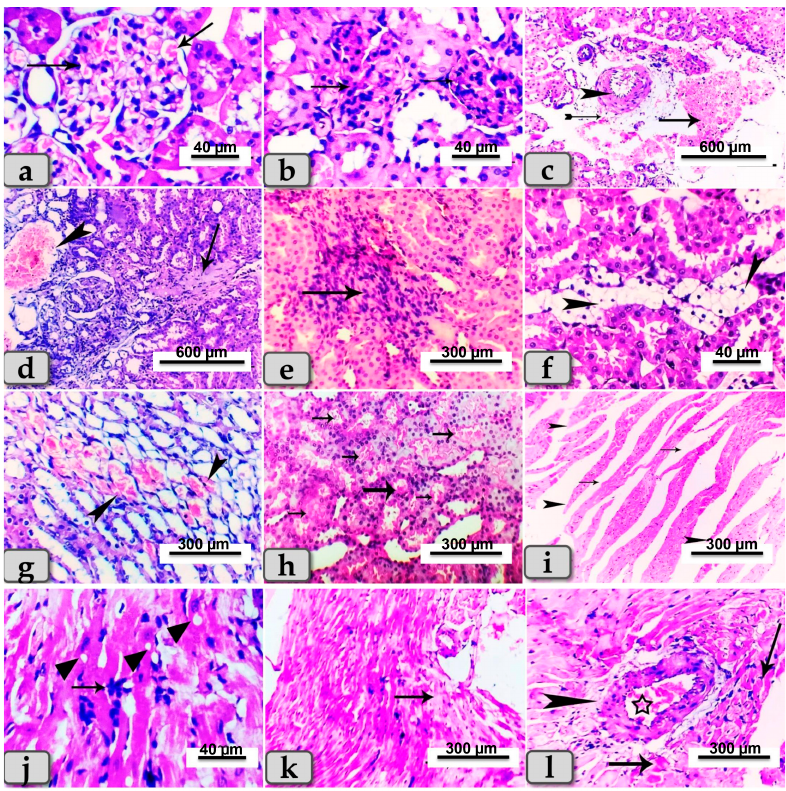
Figure 5. Photomicrographs of kidney and hearts from rats of STZ-diabetic group (Group 2). ( a ) Showing glomerulonephritis of renal cortex (arrows). ( b ) Showing hypertrophy of the renal glomeruli of renal cortex (arrow). ( c ) Showing perivascular hemorrhage of renal medulla (arrow), fi brosis (tailed arrow) and endotheliosis (arrowhead). ( d ) Showing severe blood vessel dilatations and congestion (arrow head) with focal fi brosis (arrow) and degeneration of some renal tubules in the renal cortex. ( e ) Showing focal area of in fl ammatory cell in fi ltrations and fi brosis in the renal medulla (arrow). ( f ) Showing focal vacuolations (mainly fa tt y change) of the renal lining epithelium of some renal tubules (arrowhead). ( g ) Showing focal area of cystic dilation with intra-tubular hemorrhage (arrow head). ( h ) Showing intra-tubular and inter-tubular extravasated erythrocytes (arrows). ( i ) Photomicrograph of cardiomyocytes with widening of interstitial spaces (arrows) and discontinuity of some cardiac muscle fi bers (arrowhead). ( j ) Showing in fl ammatory cell in fi ltrations (arrows) and vacuolations of variable shape and size in some cardiac myocytes (arrow head). ( k ) Showing focal areas of cardiac myocyte degenerations (arrows). ( l ) Showing hyaline degeneration of some cardiac myocytes (arrows) with perivascular fi brosis (arrow head) and congestion (star). Stain: All H&E.